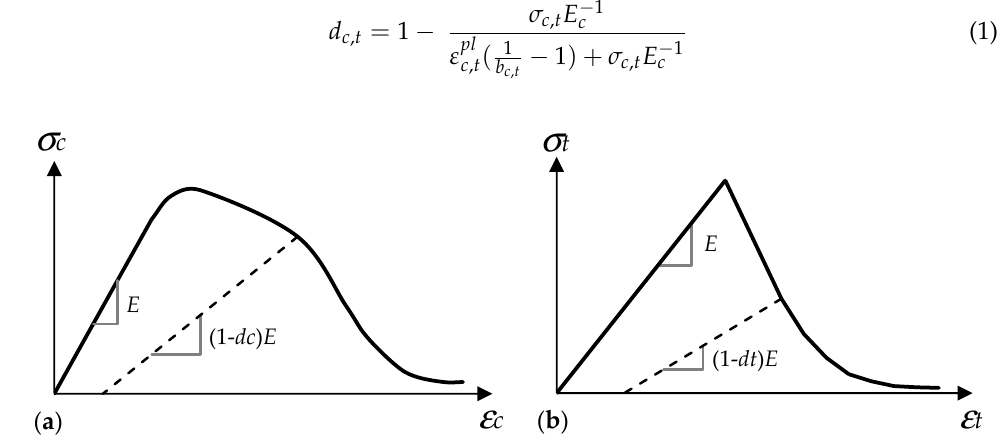
Figure 4. Damage evolution concept: ( a ) compression and ( b ) tension.